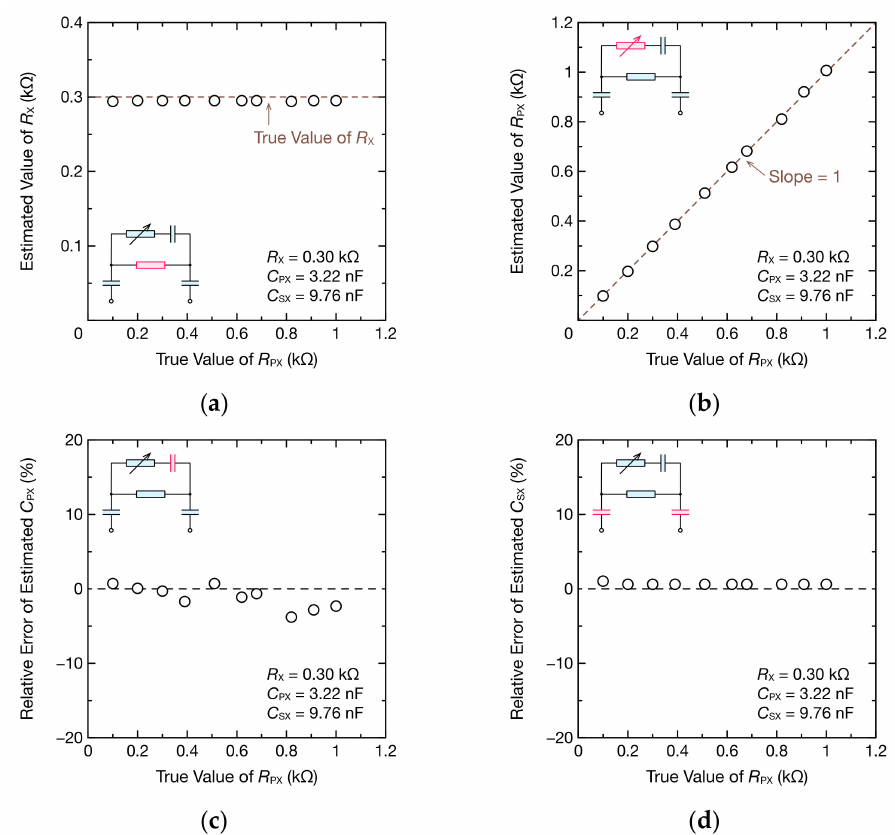
Figure 12. R X , C PX , and C SX of the bioimpedance models estimated using oscillation waveforms and DFT: ( a ) the estimated R X , ( b ) the estimated R PX , ( c ) relative error of the estimated C PX , and ( d ) relative error of the estimated C SX . The insets are the circuit models used for fitting, and the estimated parameters are highlighted in pink.